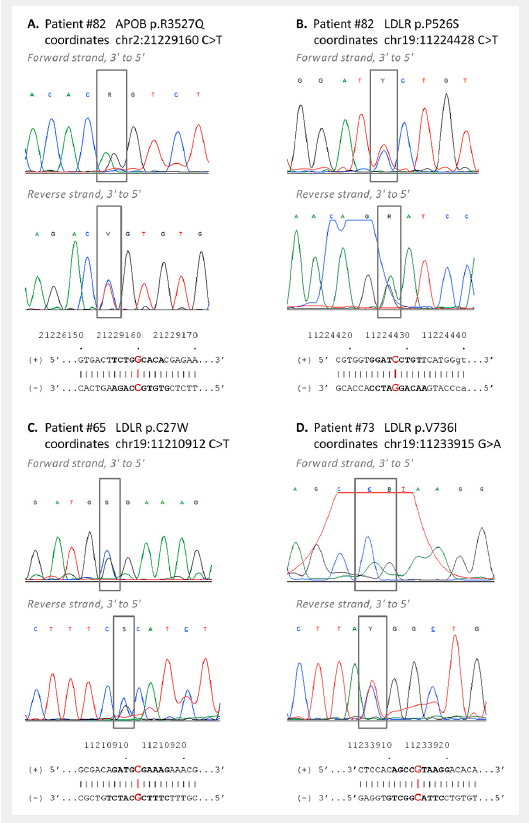
Confirmatory Sanger sequencing. The most clinically relevant variants of patients 82 (panels A, B), 65 (panel C) and 73 (panel D) were confirmed by bidirectional Sanger sequencing. Each panel shows chromatograms of the forward (top) and reverse (bottom) sequencing reactions, together with the corresponding reference sequences on the (+) and (–) strands (hg19). The variants are boxed in grey on the chromatograms; the corresponding positions on the reference sequence are highlighted in red; the stretch of reference sequence shown in the respective chromatograms is in bold letters. APOB is coded by the (-) strand, LDLR is coded by the (+) strand.